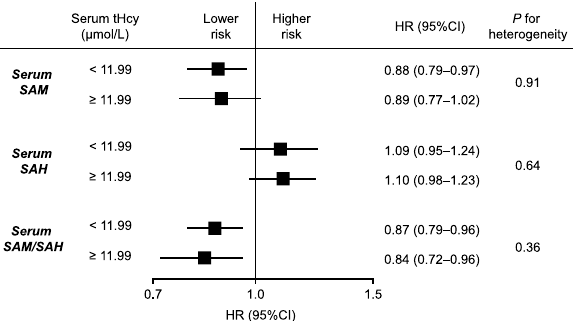
Figure 2. Association between serum SAM, SAH, and SAM/SAH ratio levels and all-cause dementia or death stratified by the levels of serum tHcy. HRs (95% CIs) of all-cause dementia or death were estimated per 1SD of the natural log transformed values of serum SAM, serum SAH, and the serum SAM/SAH ratio, respectively. The risk estimates were adjusted for age, sex, education, hypertension, diabetes mellitus, serum total cholesterol, body mass index, history of stroke, current smoking, regular exercise and use of vitamin B supplements. SAM, s-adenosylmethionine; SAH, s-adenosylhomocysteine; tHcy, total homocysteine; HR, hazard ratio; CI, confidence interval; SD, standard